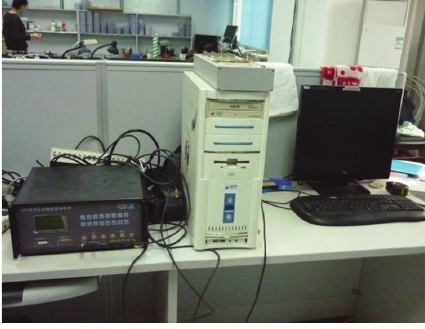
Figure 3: Computer of control